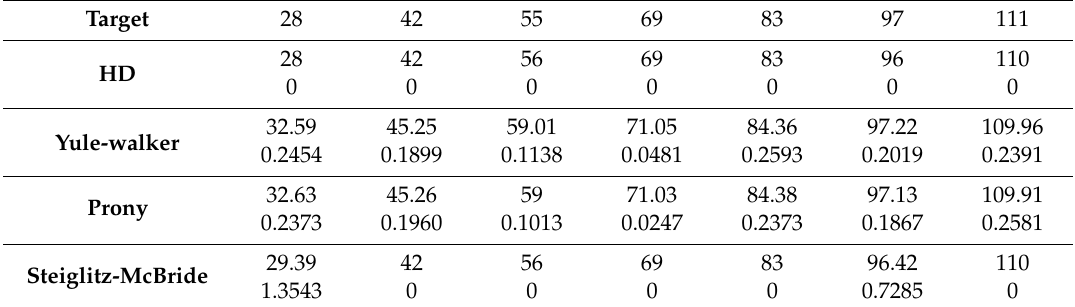
Table 4 delivers the statistical performance for long ensemble average length as 100 frames.